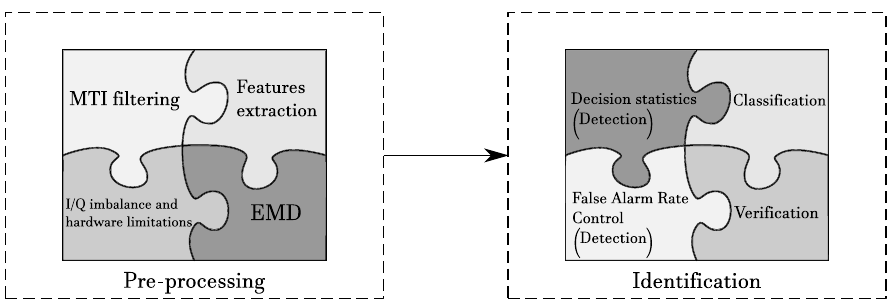
Figure 10. Jigsaw scheme of radar processing for target identification.